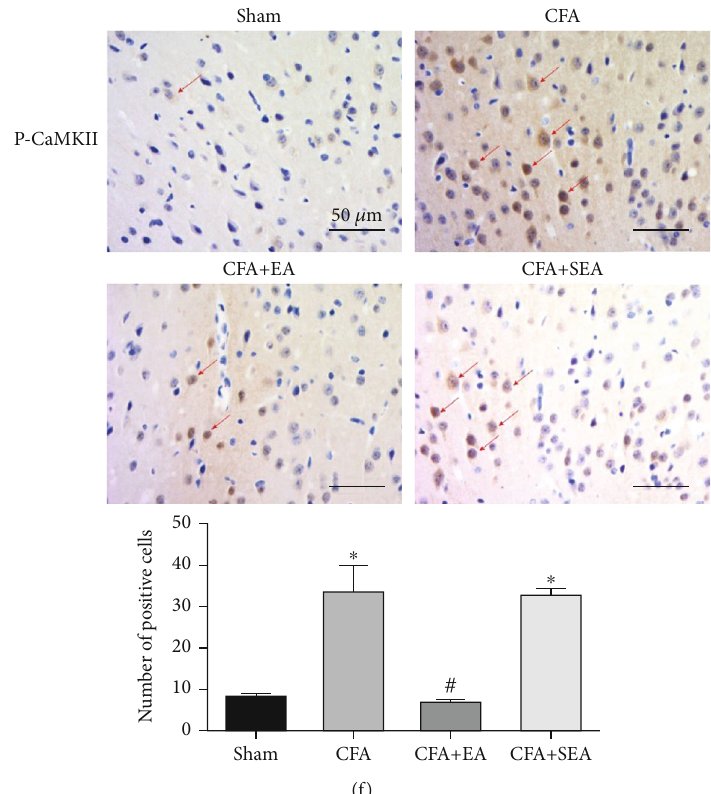
Figure 2: E ff ects of EA on the protein levels of P-CaMKII, CaMKII, P-GluA1, and GluA1. (a) Representative western blot images of P- CaMKII, CaMKII, P-GluA1, and GluA1. (b – d) Statistical analysis of P-CaMKII, CaMKII, P-GluA1, and GluA1. (f) Immunohistochemical results and statistical analysis of P-CaMKII. Scale bar = 50 μ m . Results represent the mean ± SEM ( n = 4 /group). ∗ P < 0 : 05 vs. sham group; # P < 0 : 05 vs. CFA